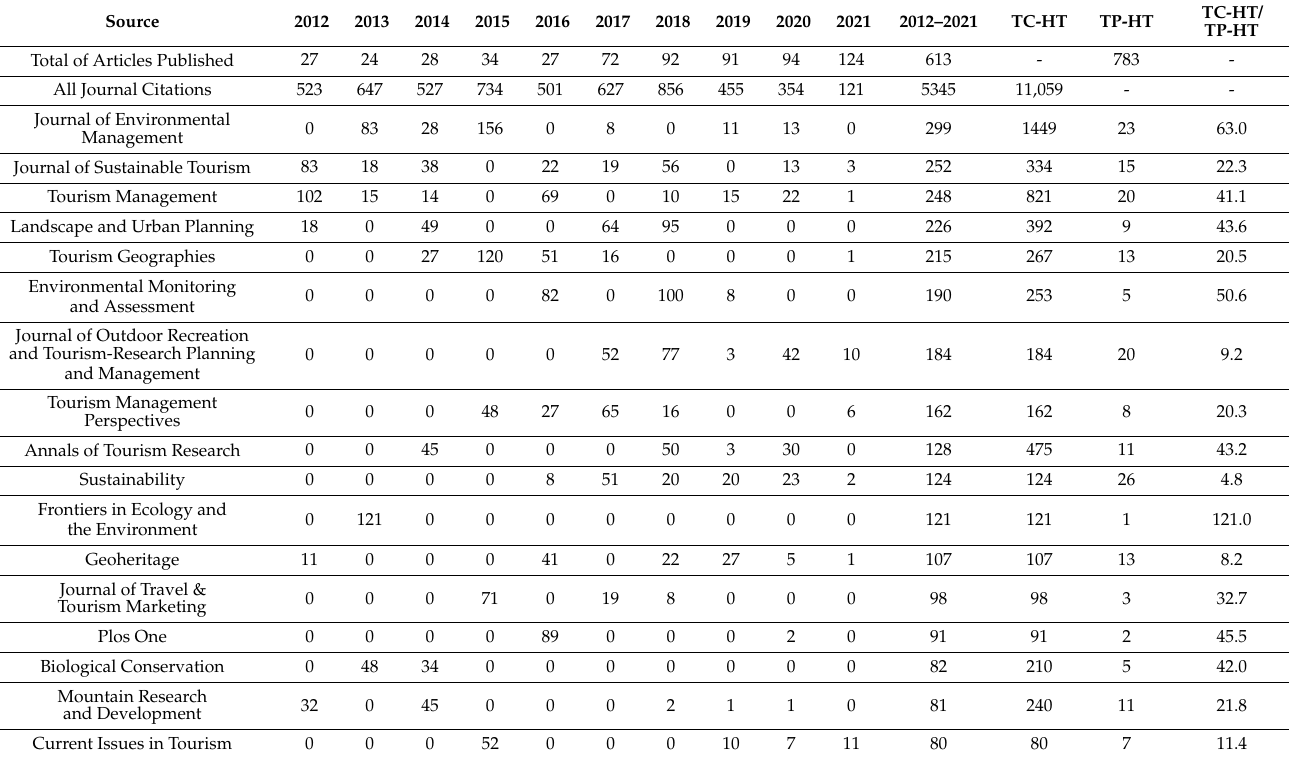
Table 2. Numbers of citations and ranks of the most-cited journals regarding hiking and trekking